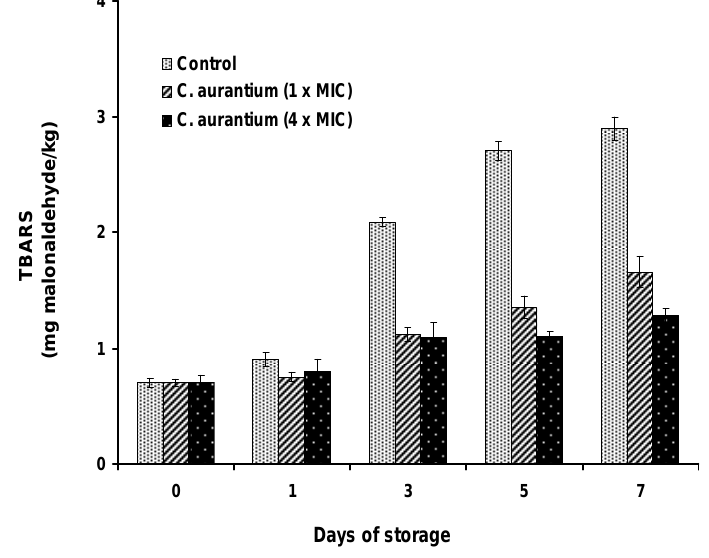
Figure 8. TBA-RS (mg malondialdehyde/kg) in Sardina pilchardus treated with bergamot EO at different concentrations and stored at 8 ± 1 °C under aerobic conditions. Error bar represents the standard deviation for triplicate experiments.